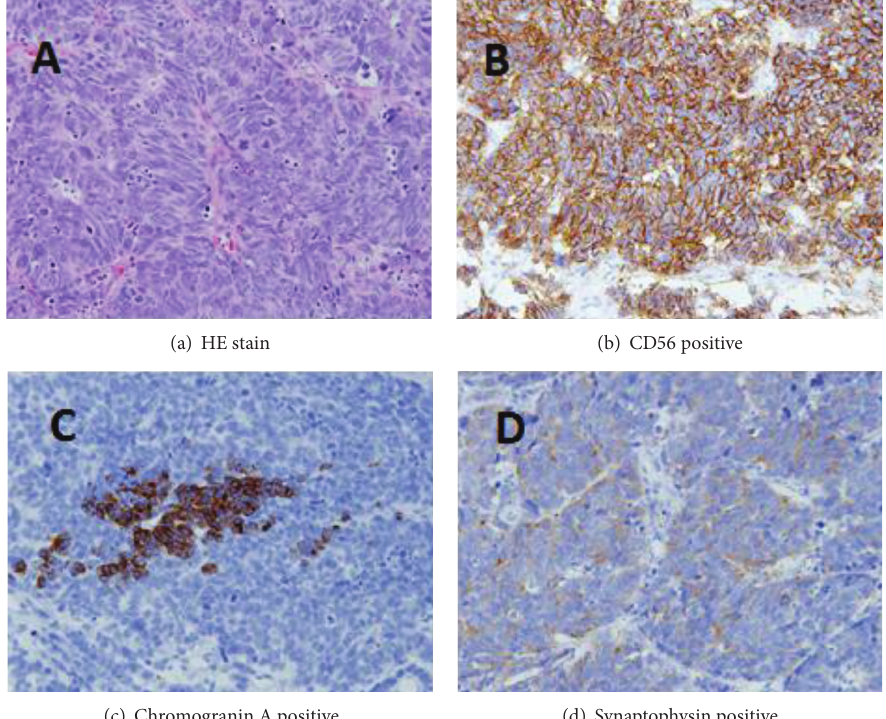
Figure 2: Histological